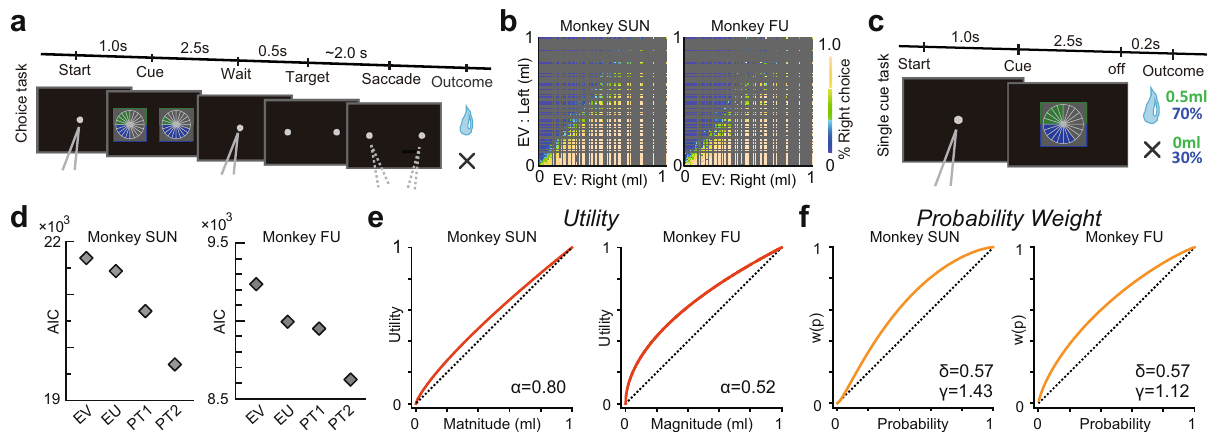
Fig.1|Cuedlotterytaskandmonkeys ’ choicebehavior.a ASequenceofeventsin thechoicetrials.Twopiechartsrepresentingavailableoptionswerepresentedtothe monkeys on the left and right sides of the screen. The monkeys chose either of